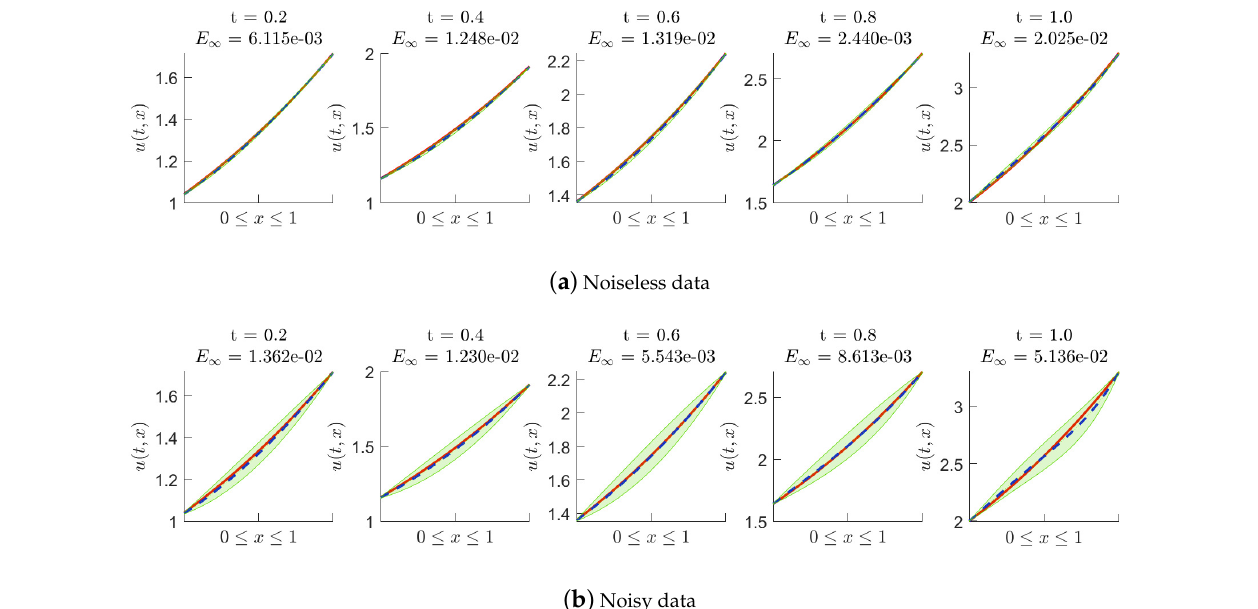
Figure 4. Fractional equation of Example 1: the posterior distribution of the predicted solution at different time nodes, where ( α , β ) is fixed to be ( 0.75,0.25 ) . Noiseless data and noisy data are used, respectively.